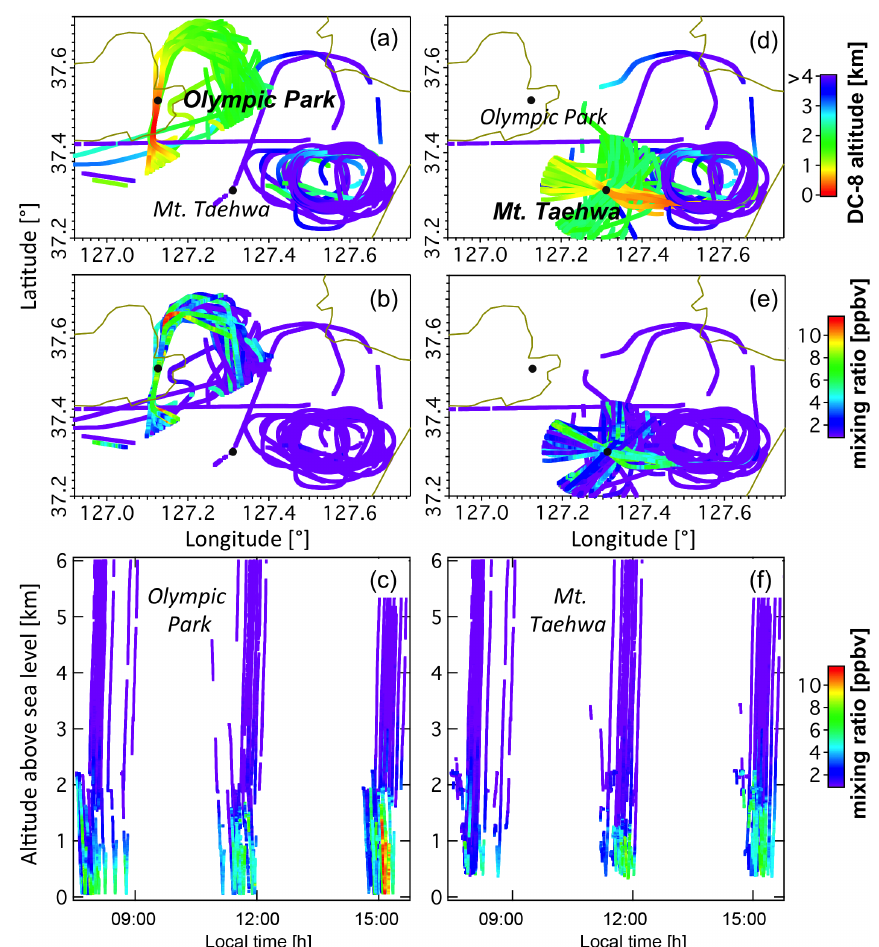
Figure 4. Summary of all DC-8 flights over Olympic Park and Mt. Taehwa: (a, d) DC-8 GPS altitude above sea level, (b, e) HCHO mixing ratios measured on board DC-8 as a function of latitude and longitude, and (c, f) HCHO mixing ratios measured on board DC-8 as a function of altitude and local time. Distance between Mt. Taehwa and Olympic Park sites is approximately